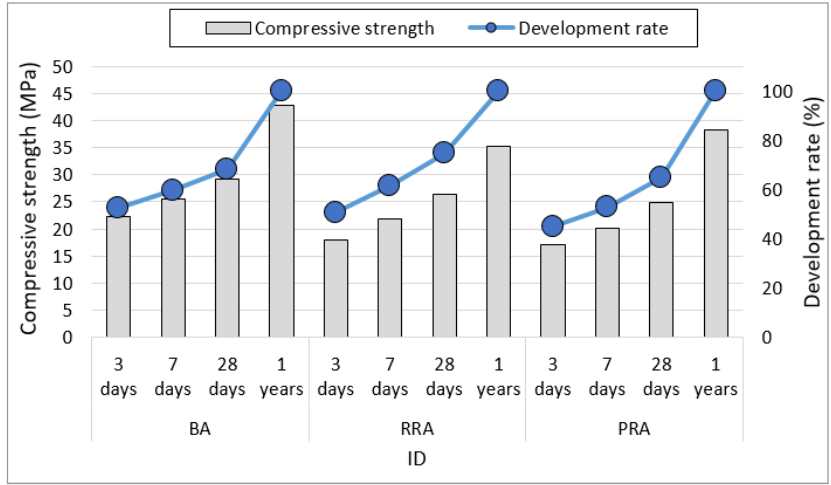
Figure 9. Compressive strength and development of concrete depending on